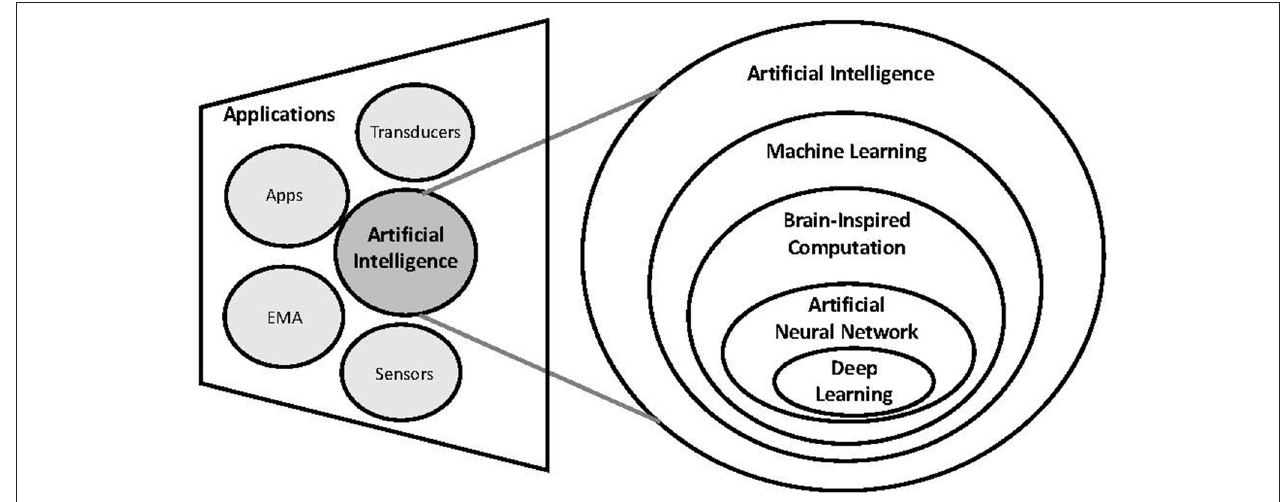
FIGURE 4 | Analytical Artificial Intelligence methods and applications in